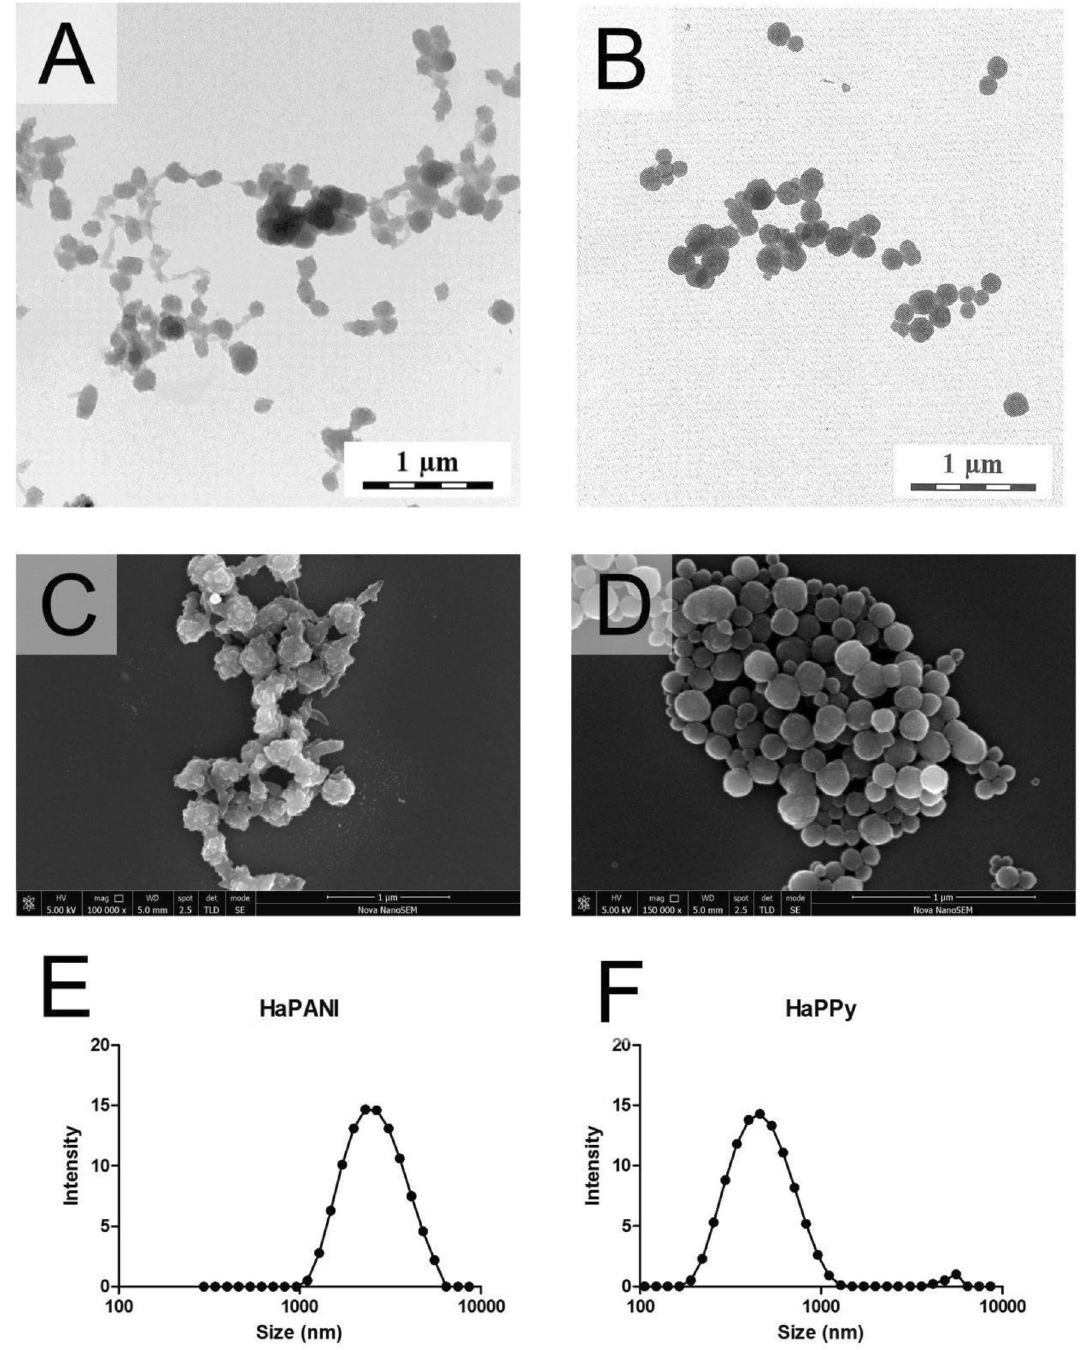
Figure 1. Transmission electron micrographs of CP-based colloidal particles stabilized with sodium hyaluronate HaPANI ( A ), HaPPy ( B ); scanning electron micrographs of corresponding particles HaPANI ( C ), HaPPy ( D ) and particle size distribution curves of HaPANI ( E ), HaPPy ( F ). The particle size analyses were run in